Question: Which visualization type does this figure use?
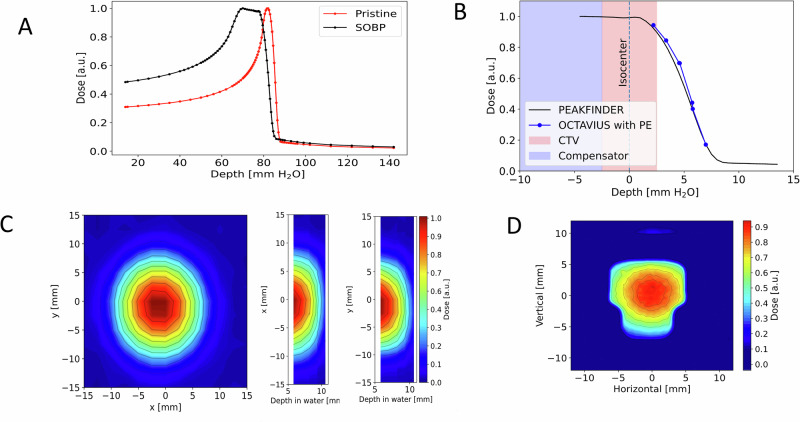
Answer: line